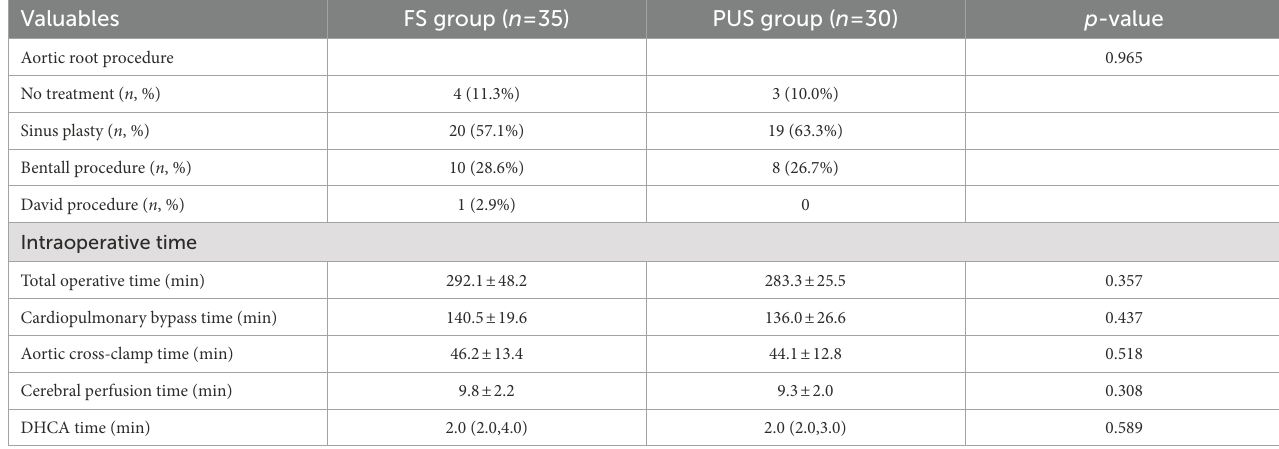
TABLE 2 Comparison of intraoperative conditions between the two groups ( n = 65). Valuables